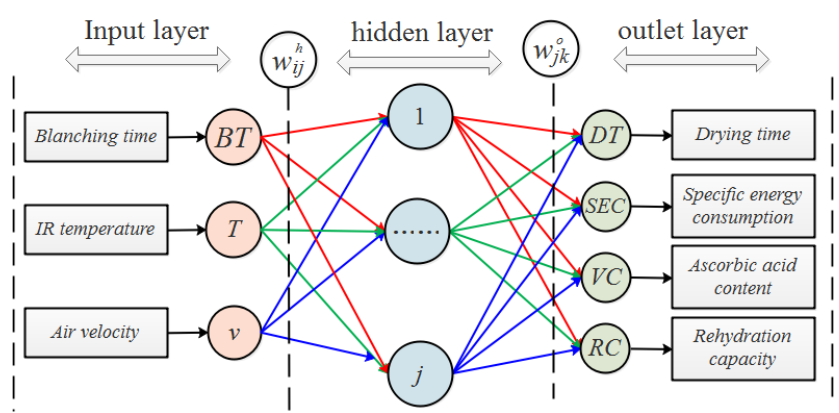
Figure 4. Structure of the ANN model.